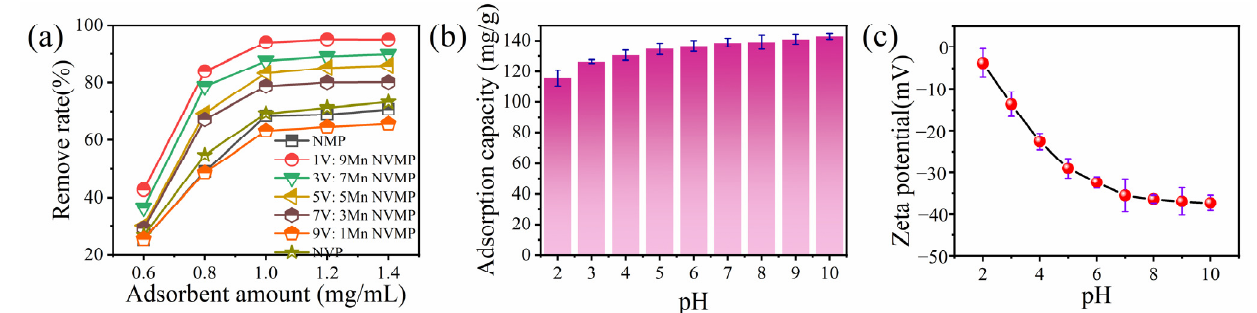
Figure 2. ( a ) The adsorbent dosage on the adsorption capacity of Sr 2+ , ( b ) zeta potential of 1V: 9Mn at di ff erent pH values, ( c ) removal e ffi ciency of Sr 2+ with 1V: 9Mn at di ff erent pH